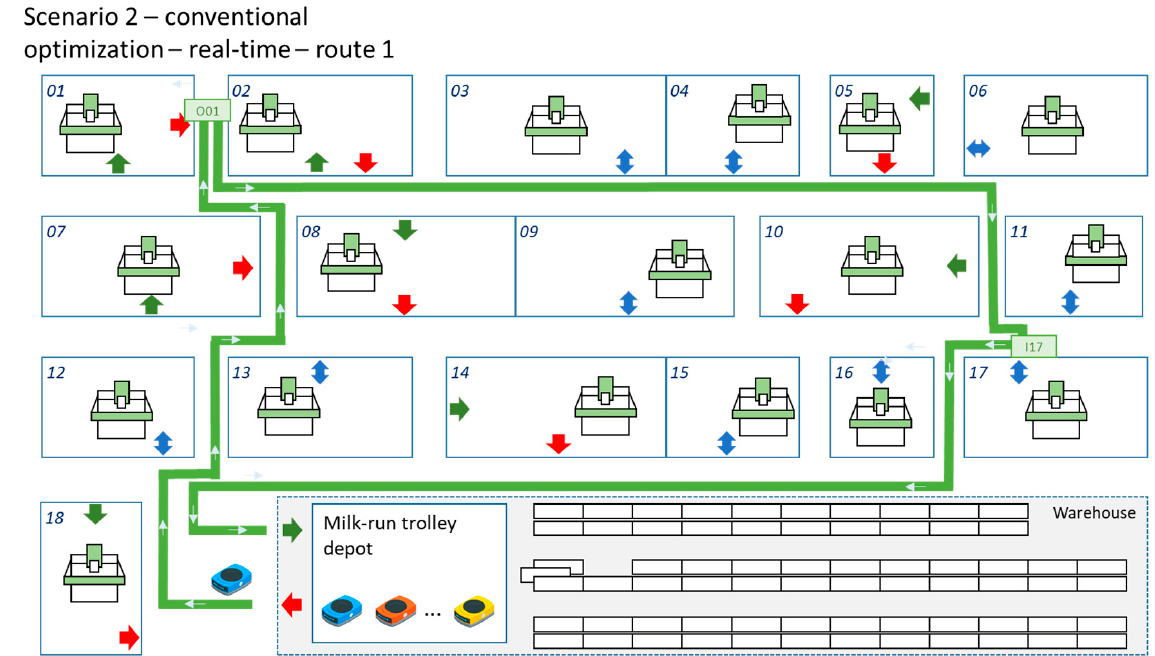
Figure 8. The first route of the conventional milk-run-based in-plant supply including real-time supply demand.